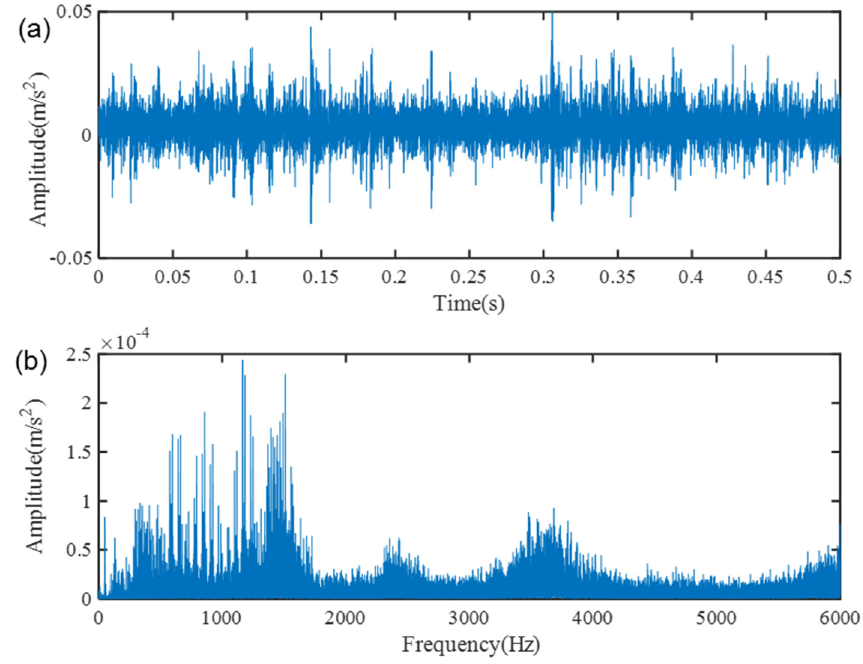
Figure 13. The supporting bearing vibration signal: ( a ) waveform; ( b ) spectrum.